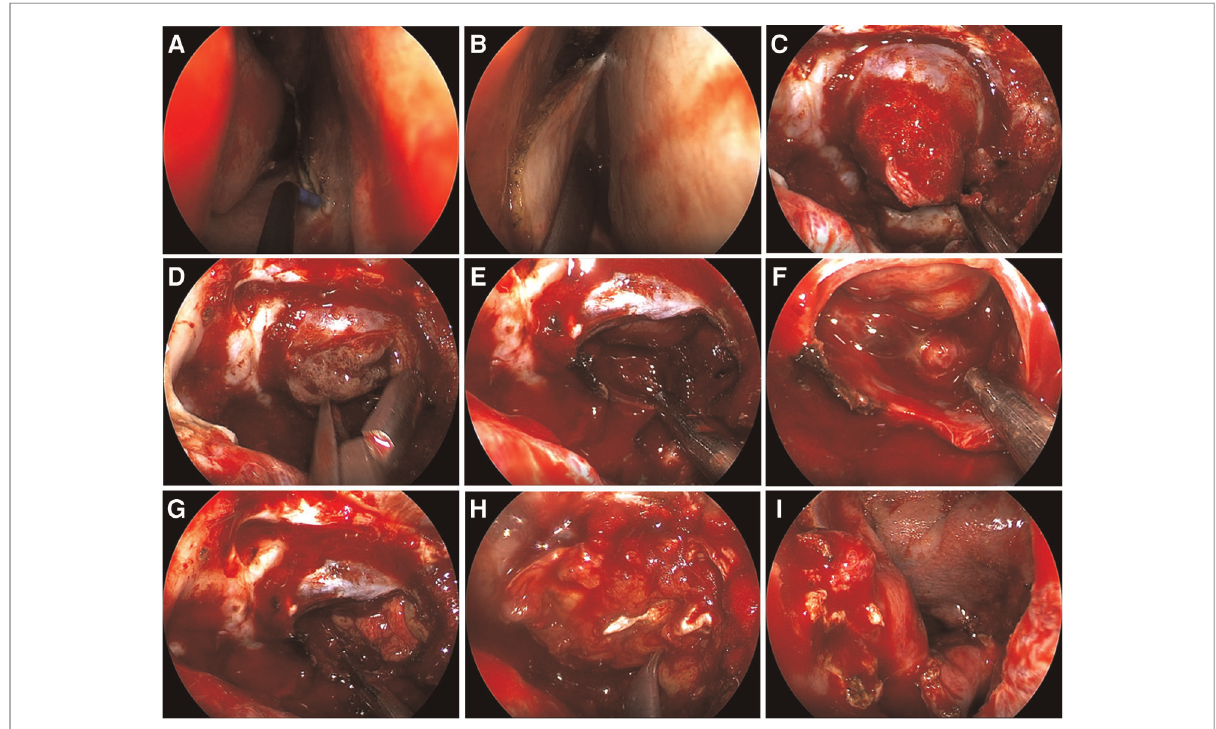
FIGURE 5 Rigorous skull base reconstruction procedure. ( A,B ) A pedicled nasoseptal fl ap was prepared in advance. ( C ) The tumor eroded the dura mater and protruded into the sphenoid sinus. ( D ) The tumor is removed in steps. ( E,F ) Pituitary adenoma has been completely removed and intraoperative CSF leakage occurred. ( G ) The fat graft was placed. ( H ) The fascia lata graft was placed. ( I ) The pedicled nasoseptal fl ap was placed over the fascia lata